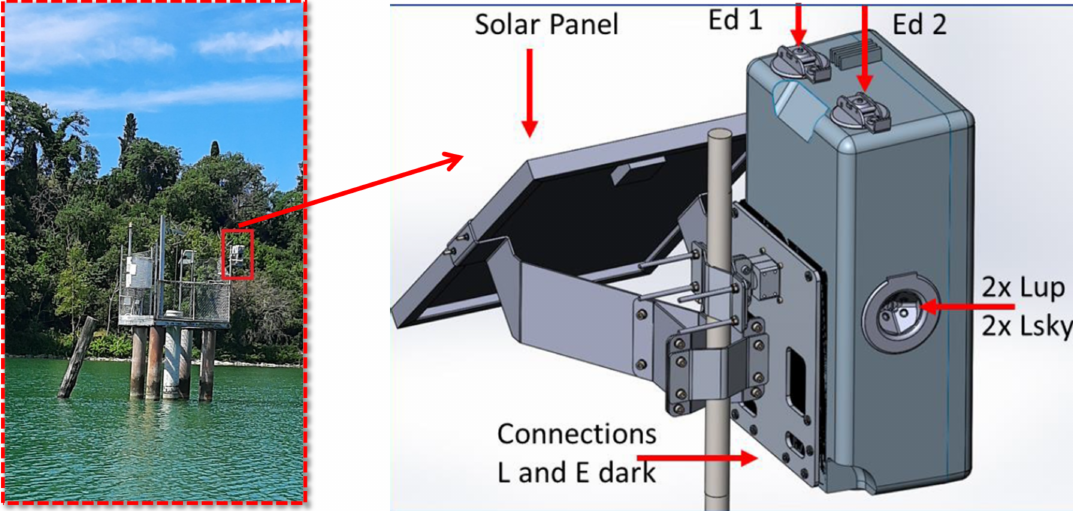
Figure 2. Photograph of the WISPstation in Lake Trasimeno (Italy). Red box in photo indicates the layout and installation of the instrument which is further detailed in the diagram on the right from Peters et al. [61] as follows: 2 Radiance channels collecting Lup and Lsky in the NNW direction; 2 Radiance channels collecting Lup and Lsky in the NNE direction; 2 Irradiance channels (Ed); 1 unexposed dark radiance (L) channel for evaluation of radiance channel degradation; 1 unexposed dark irradiance (E) channel for evaluation of the degradation of irradiance